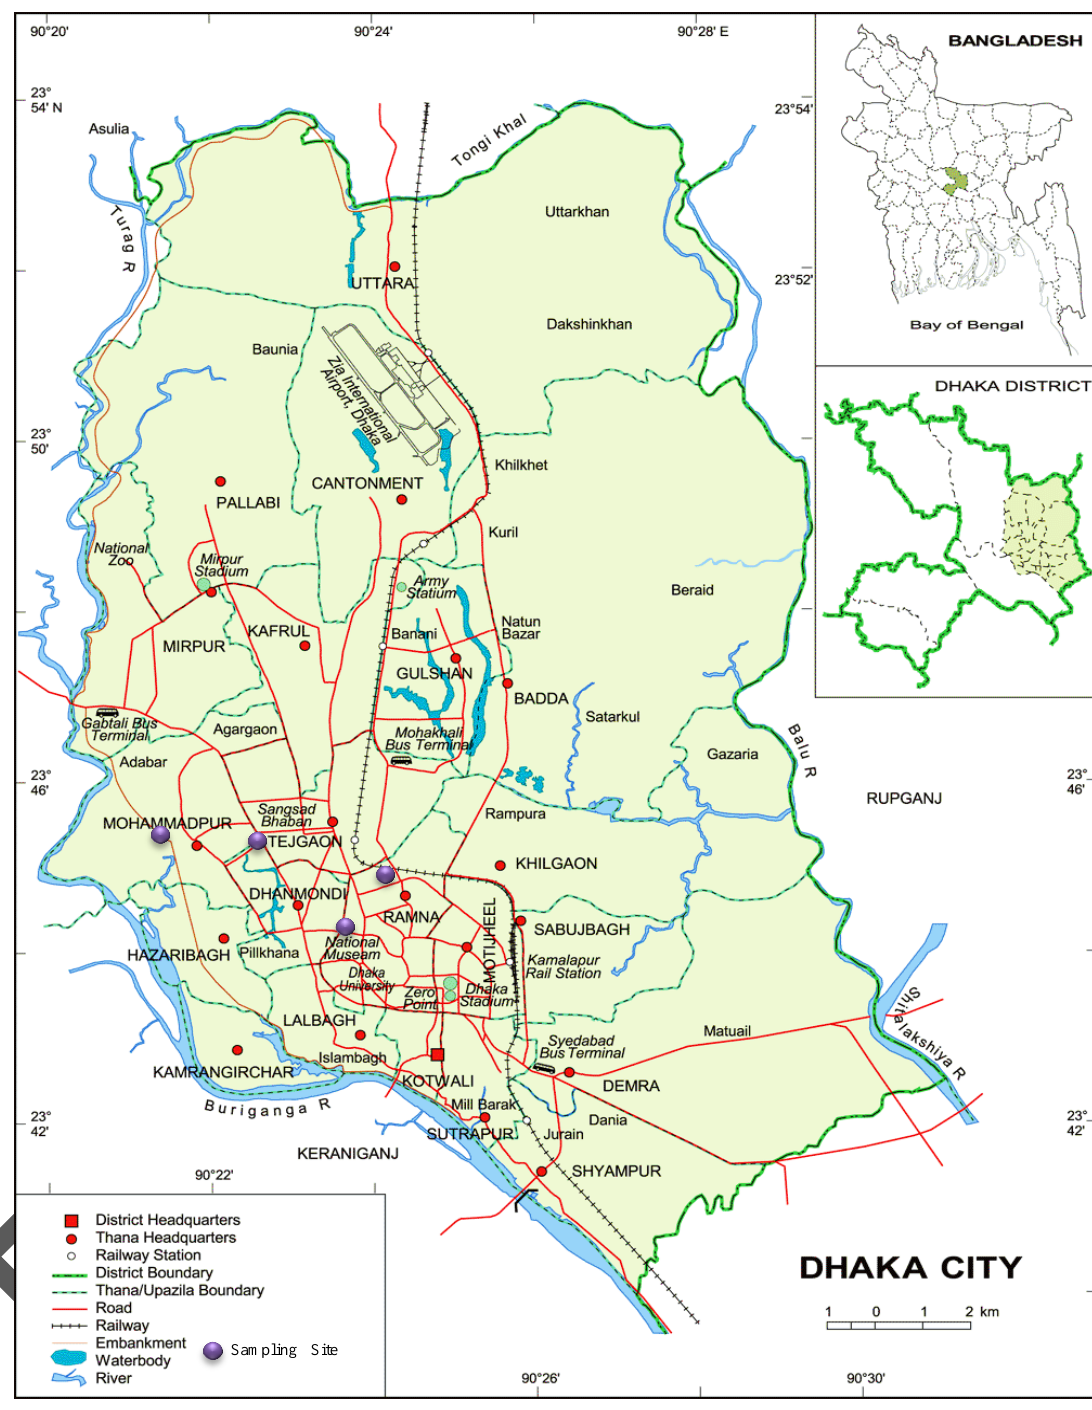
Figure 1. Map of Dhaka city showing the sampling sites.